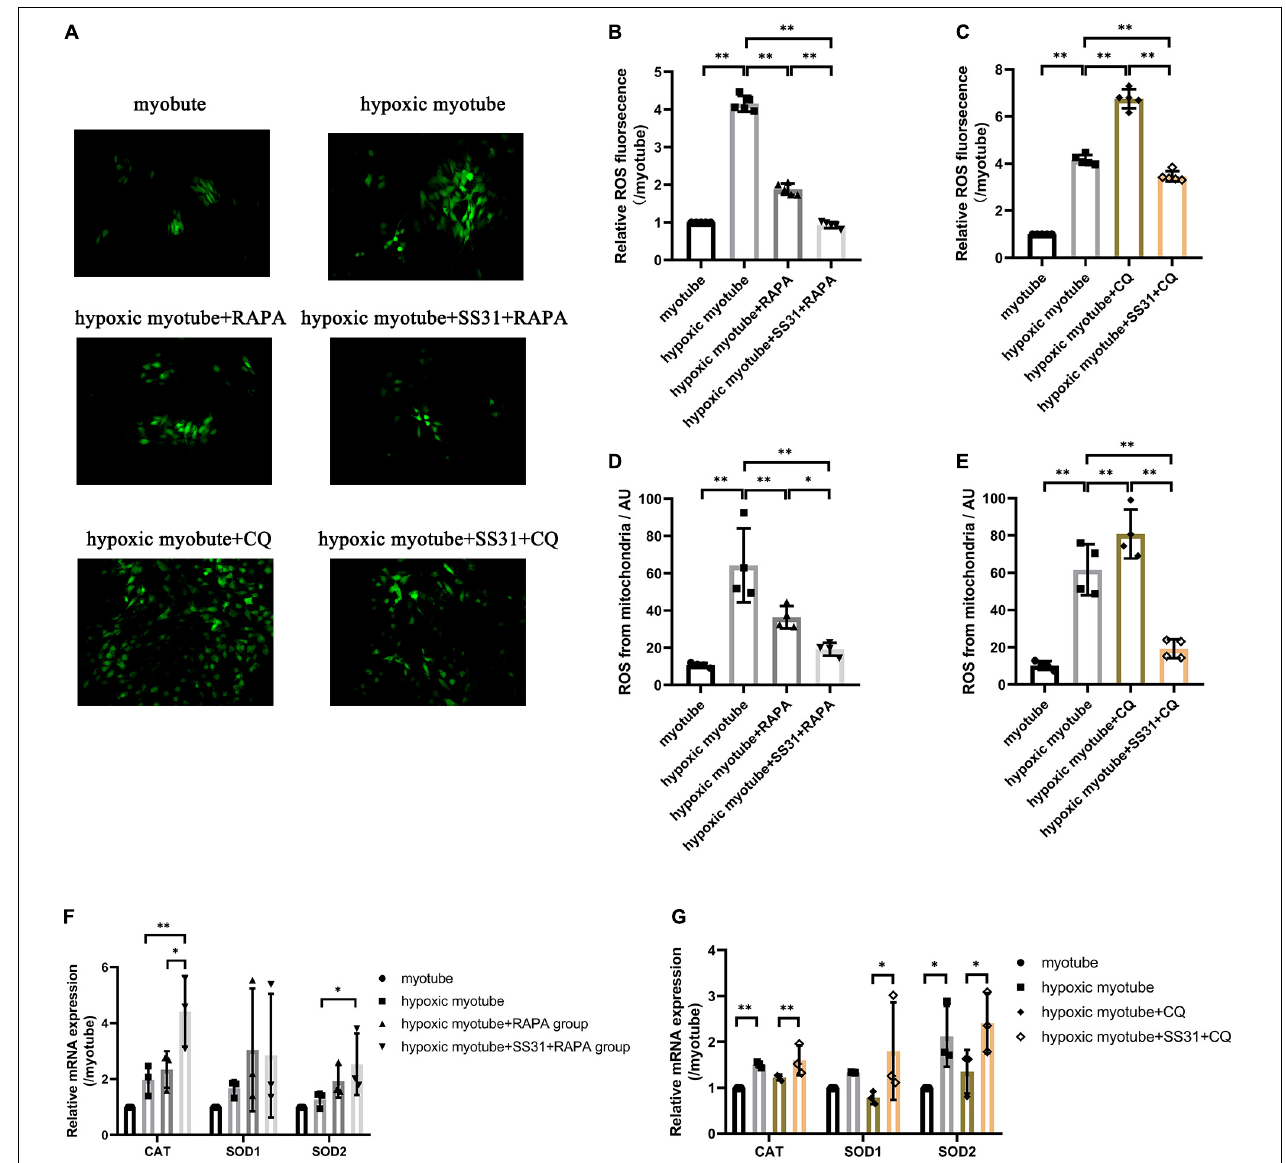
FIGURE 5 | SS31 attenuates oxidative stress in C2C12 myotubes. (A–C) ROS contents in C2C12 myotubes. (D,E) DCFH-DA staining analysis revealed the mitochondrial ROS levels. (F,G) The relative mRNA expression levels of SOD1, SOD2, and CAT were detected by RT-qPCR. The data were standardized on the basis of the GAPDH level, n = 3–5. ∗ p < 0.05, ∗∗ p <